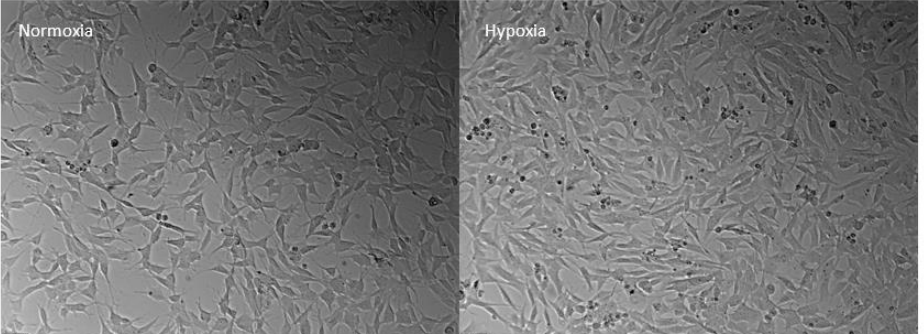
Figure 11. Representative images of SH-SY5Y cells submitted to normoxia ( left ) and hypoxia ( right ) conditions for 48 h. Images of cell morphology were obtained using Leica microscope equipped with Leica LAS X imaging software v3.7.4 (Leica Microsystems, Wetzlar, Germany). Scale bar: 50 µ